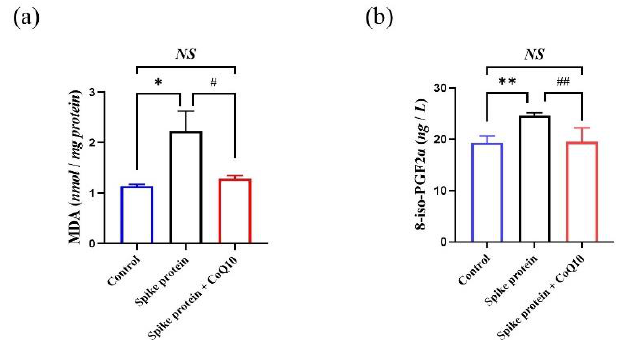
Figure 6. CoQ10 inhibits platelet oxidative lipid damage induced by spike protein. Gel-filtered platelets were incubated with CoQ10 or solvent for 50 min, then incubated with spike protein for 10 min, then stimulated with thrombin for 10 min. ( a ) Platelets pellet was lysed for MDA analysis ( n = 5). ( b ) Supernatant was used for 8-iso- PGF2α level detection ( n = 4). All data are presented as mean ± SEM. * p < 0.05, ** p < 0.01 indicate a significant difference compared to the control group. # p < 0.05, ## p < 0.01 indicate a significant difference between two groups. NS , no significant difference between two groups.